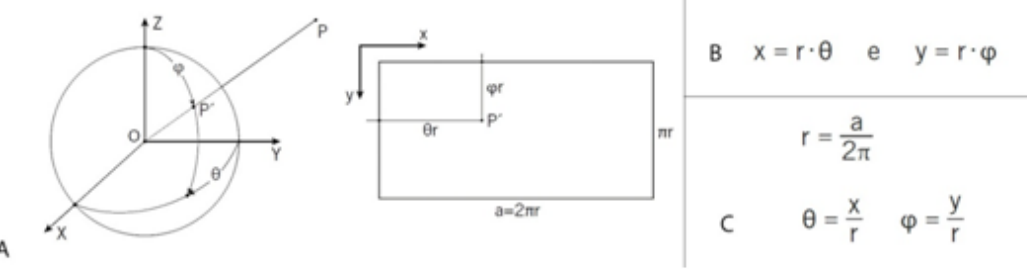
Figure. 2 Relations between spherical co-ordinates and co-ordinates on spherical photographs (Fangi,